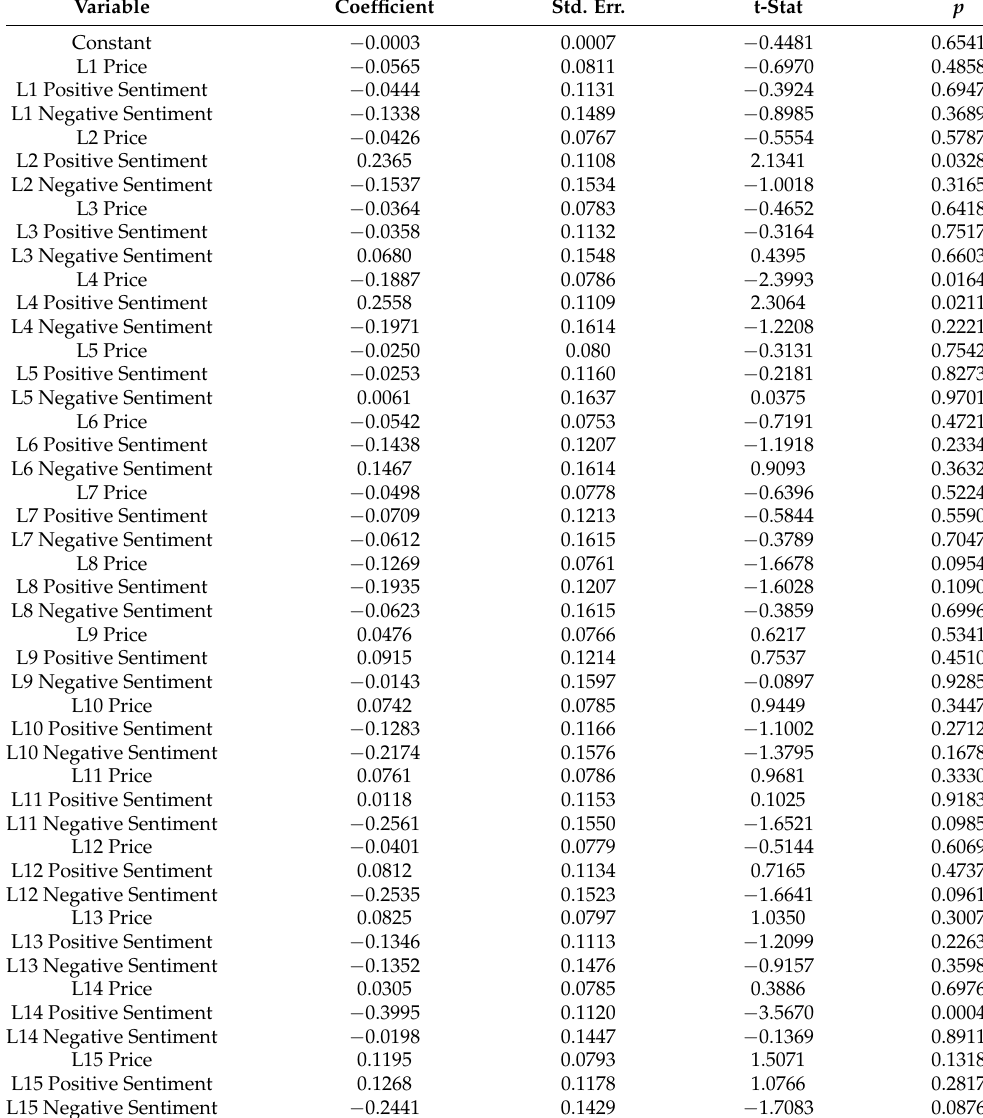
Table A1. VAR results for the regressions on the price of Dogecoin. Optimal lag length was selected using a built in function in the VAR submodule of the statsmodels module in Python. Lx before a variable name denotes that a variable was lagged × times.